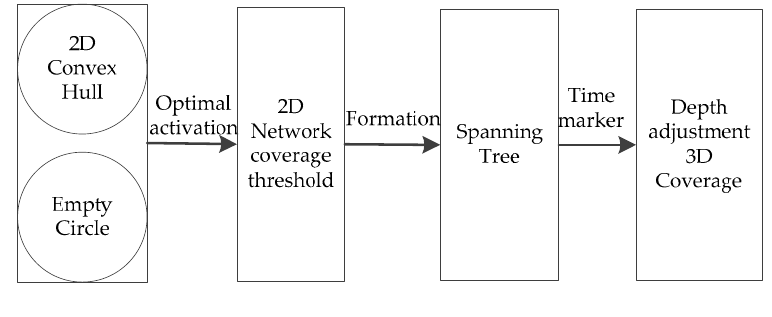
Figure 4. Algorithm framework.